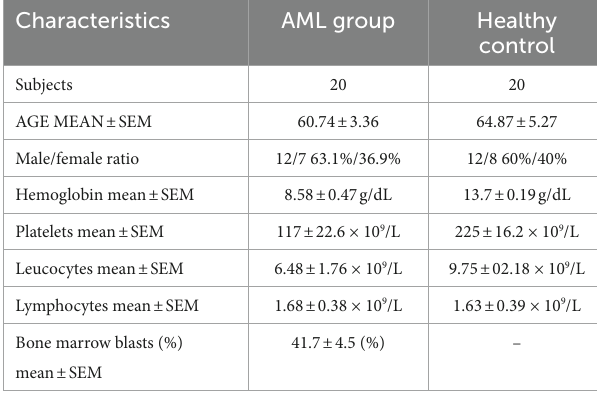
TABLE 1 Subjects characteristics.